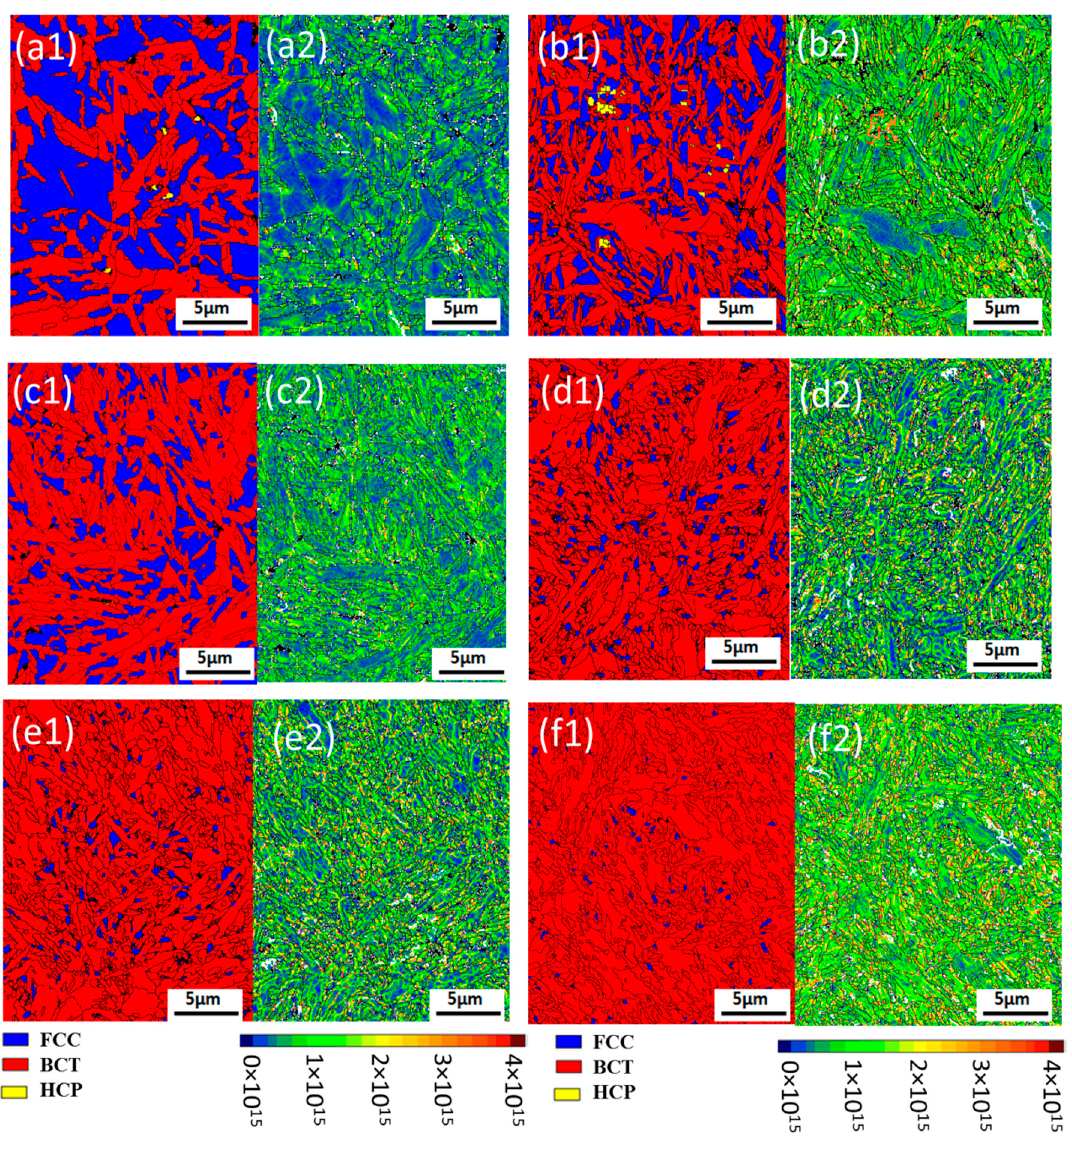
Figure 3. EBSD micrograph of the material ( a1 ) phase map & ( a2 ) dislocation density map of base material; ( b1 ) phase map & ( b2 ) dislocation density of 2 × 10 − 5 /s; ( c1 ) phase map & ( c2 ) dislocation density of 2 × 10 − 4 /s; ( d1 ) phase map & ( d2 ) dislocation density of 2 × 10 − 3 /s; ( e1 ) phase map & ( e2 ) dislocation density of 2 × 10 − 2 /s; ( f1 ) phase map & ( f2 ) dislocation density of 2 × 10 − 1 /s strain rate induced samples.